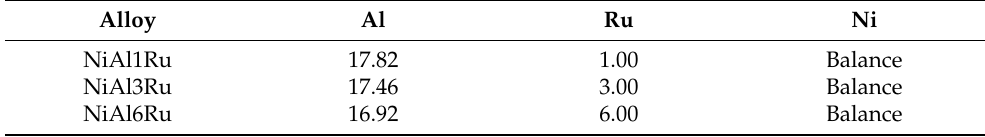
Table 1. Composition of the designed alloys